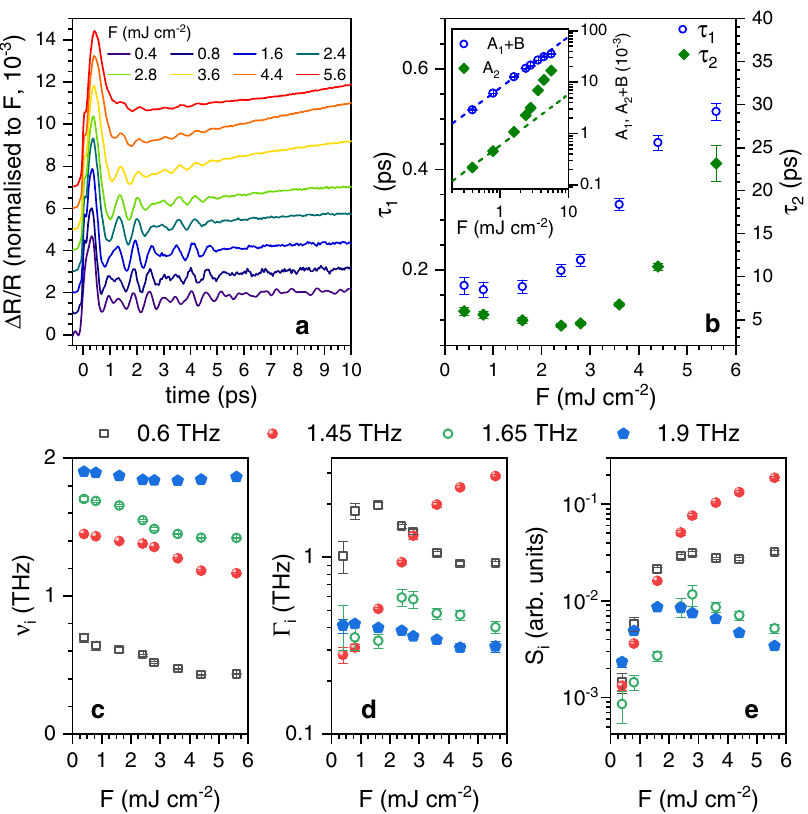
Fig. 5 Excitation density dependence of collective dynamics recorded at 10 K. a Re fl ectivity transients, Δ R / R ( t ), normalized to the excitation fl uence, F . b The extracted relaxation timescales τ 1 and τ 2 as a function of F . Inset presents the F -dependence of amplitudes, with dashed lines presenting linear fi ts. c – e F -dependence of the collective mode parameters ν i , Γ i , S i . The error bars are obtained from the standard deviation of the least-squared fi